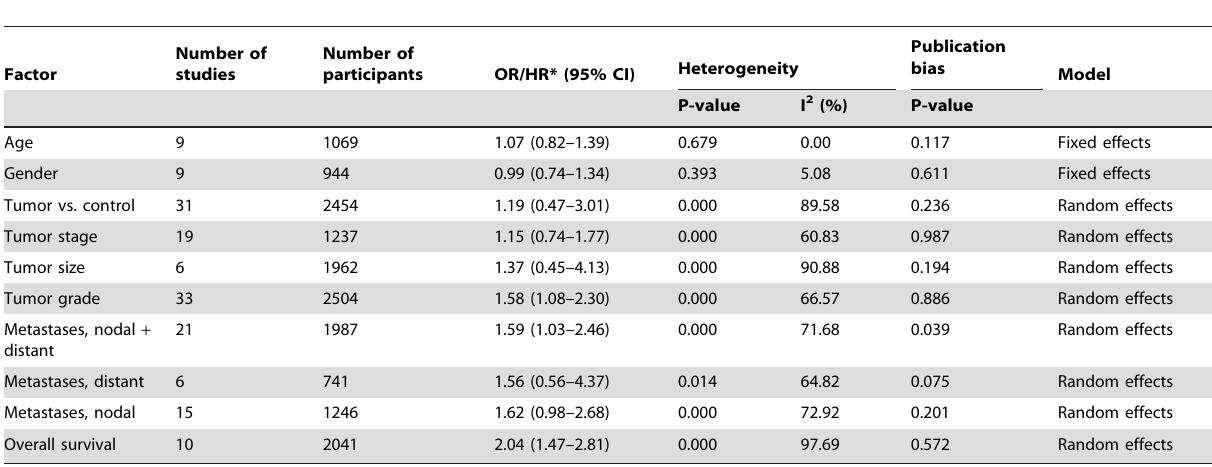
Table 1. Association of MT staining and clinicopatological factors. Tumor type not taken into